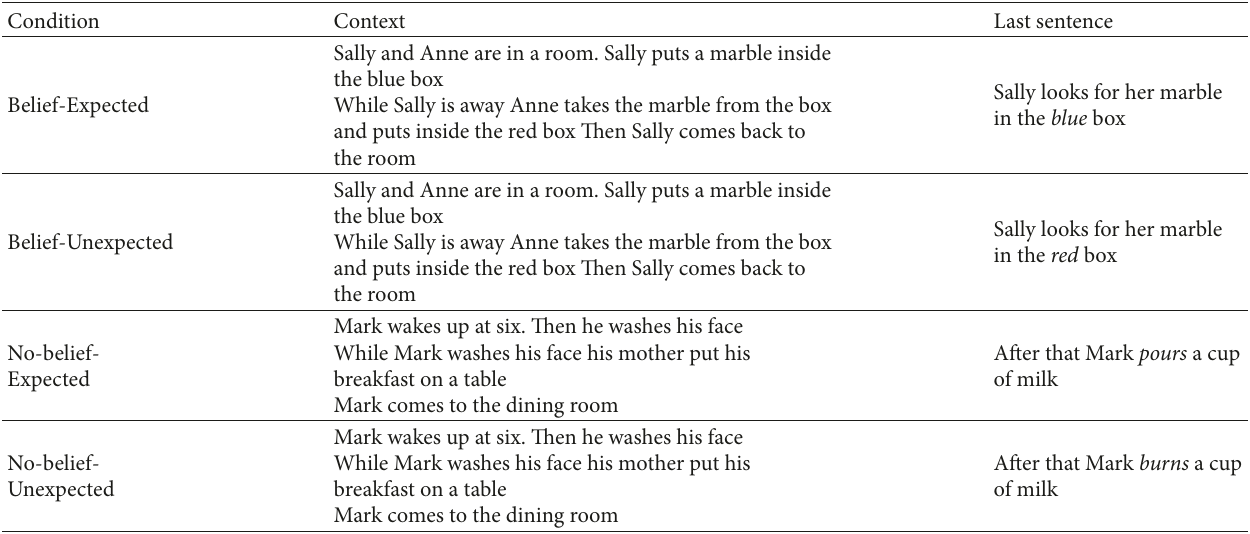
Table 1: Examples of stimulus sentences (target words are